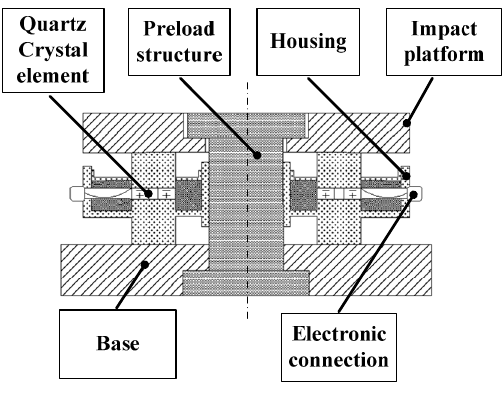
Figure 5. Schematic representation of piezoelectric cutting force sensor.